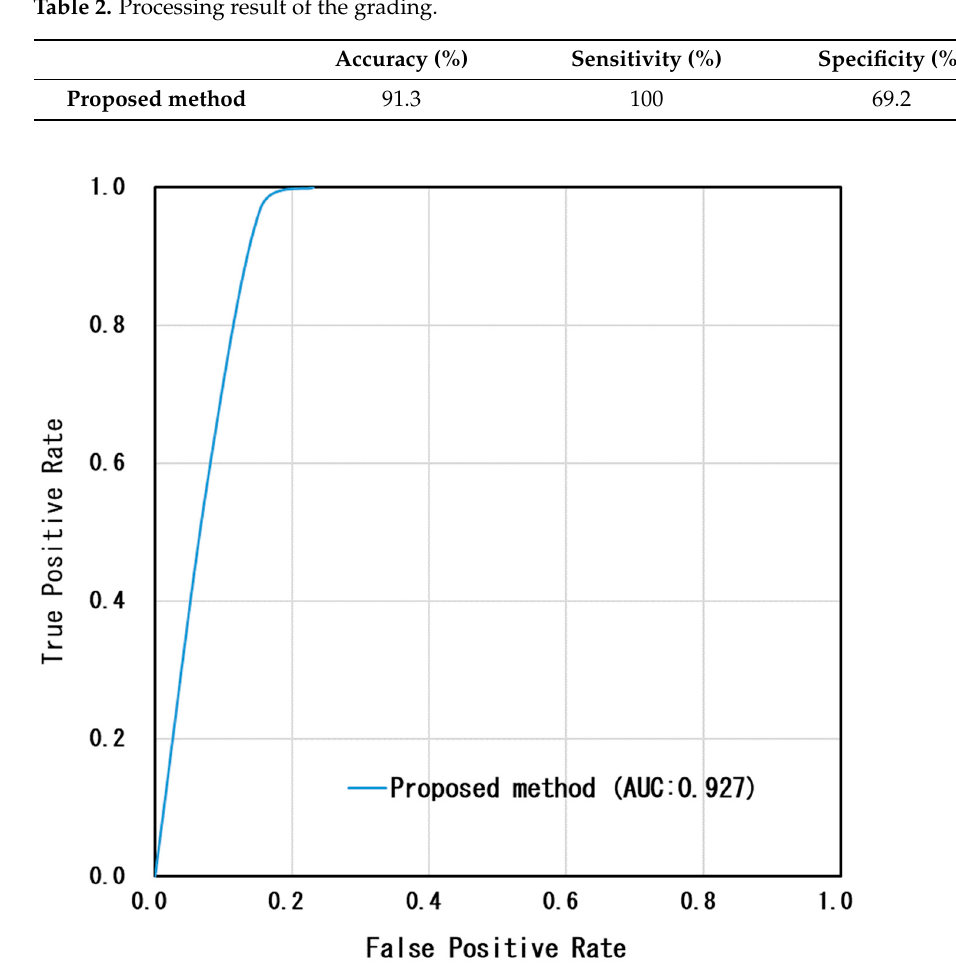
Figure 6. ROC curve and AUC for proposed method.